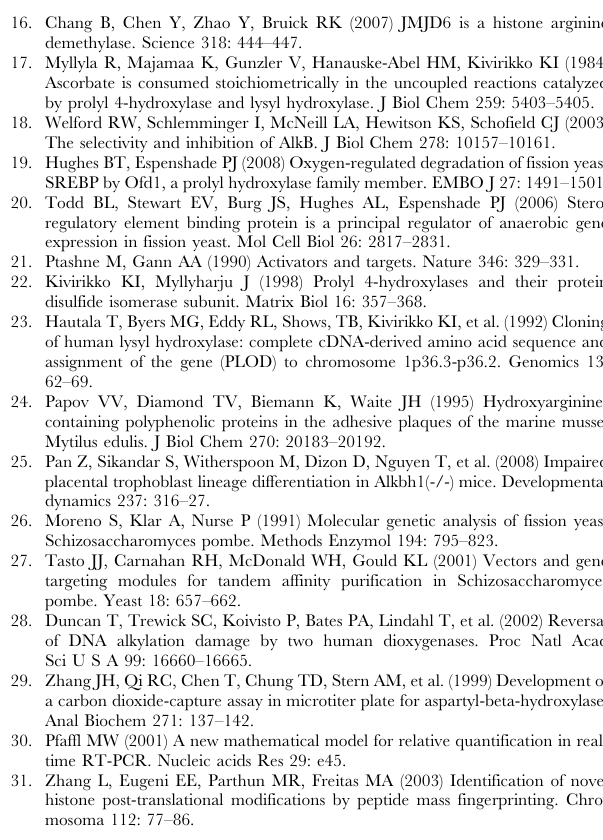
is presented as mean from 2 replicates. Error bar equals 1 standard deviation. Figure S2 Substitutional analysis of peptide sequence C7. Substitutional analysis of peptide sequence C7 with the CO 2 capture assay using 1 m g of Ofd2 with 6 m g of peptide. Alanine and glycine substitutions are indicated in red. Data is from 2 replicates presented as a percent activity of captured CO 2 relative to unmodified C7 peptide. Error bars equal 1 standard deviation. Figure S3 Hypoxia gene expression analysis of Ofd2 deletion strain. Scatter plot analysis of fold change in gene expression after hypoxic treatment plotted as log2 values in wt against Ofd2 D strain. Blue squares represent genes whose expres- sion change was less than 2 fold in both strains. While green and red squares represent genes whose expression increased or decreased 2 fold or greater, in one or both strains. The gray line represents a threshold limit of 1.5 fold above and below values where the induced or repressed fold change for both wt and Ofd2 would be the same. Shaded box contain repressed genes that lie outside the threshold limit. Table S1 Array data set for all genes. (XLS) Table S2 Greater than 2 fold hypoxically upregulated genes in wt strain.